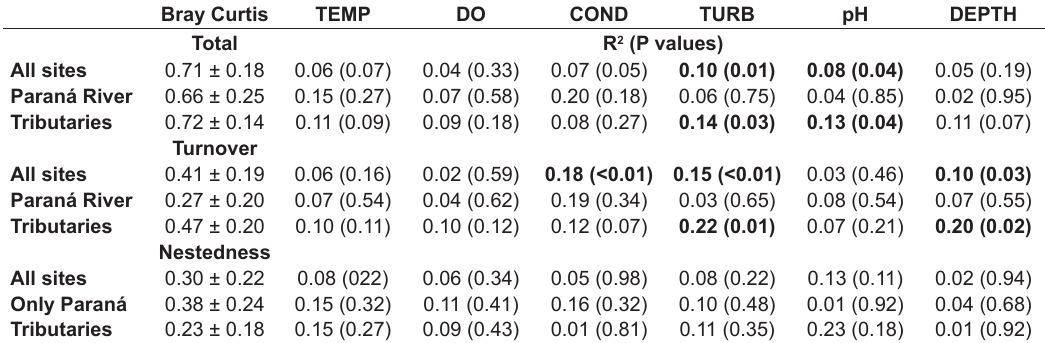
Figure 3. Non-metric multidimensional ordination of species composition of fish assemblages at the Upper Paraná River. Stress = 0.1495. Squares: sites in the northern portion of the sampled region (Paranapanema, Baía and Ivinhema rivers); triangles: sites in the middle portion of the sampled region (Ivinheminha, Ivaí and Amambaí rivers); diamonds: sites on the left side of the sampled region (Paracaí, São João and Xambrê); circles: sites in the southern and right side of the sampled region (Maracaí, Pirajuí and Iguatemi rivers). See species names in Table 1. Table 2. Partition of beta diversity (mean and standard deviation of Bray Curtis dissimilarity) for fish assemblages and its relationship with environmental variables (R 2 and P-values) in the Upper Paraná River. TEMP: water temperature; DO: dissolved oxygen; COND: conductivity; DEPTH: mean depth. Significant relationships in